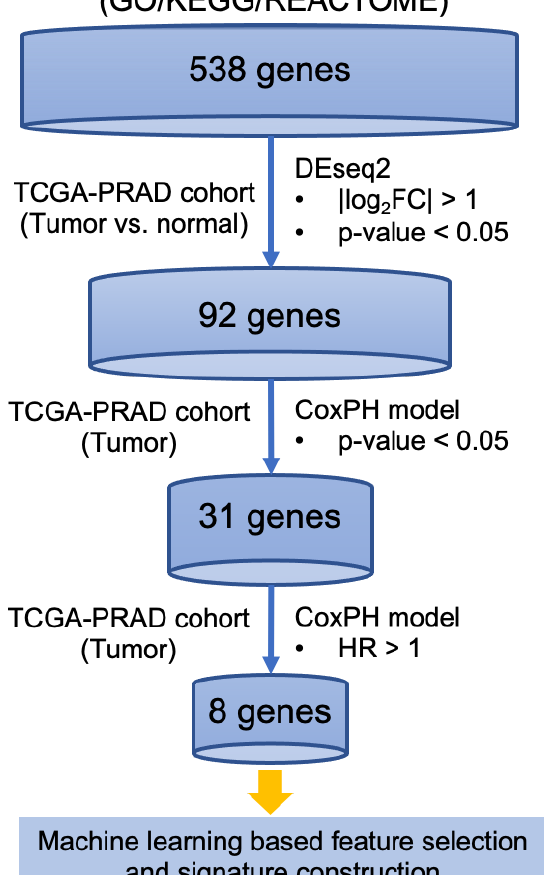
Figure 1. The signature exploration workflow. The workflow of generating the 8-gene signature associated with steroid hormone and prostate cancer progression. Table 1. The differential expression and hazard ratio (HR) of progression-free interval (PFI). The log 2 fold change and corresponding HR of PFI of each of the 8